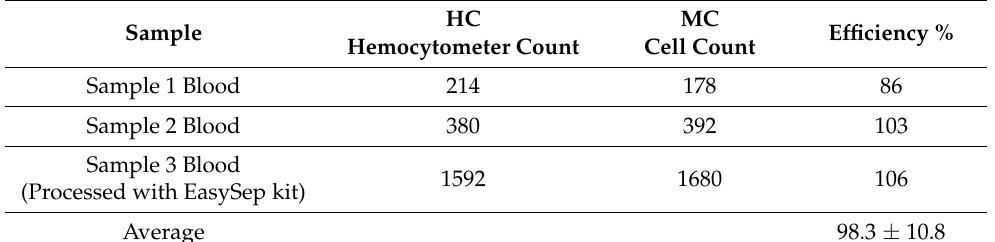
Table 1. Process efficiency of the micromodule based on inverted microscope (Nikon Eclipse TE2000- S)